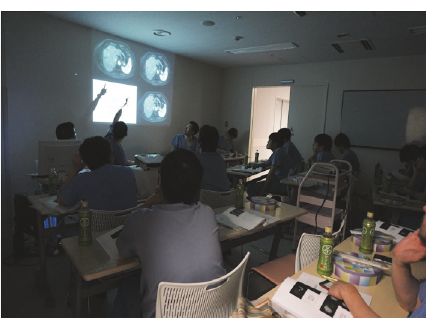
Figure 5: In case studies, difficult to ablate cases from participants’ institutions are presented and